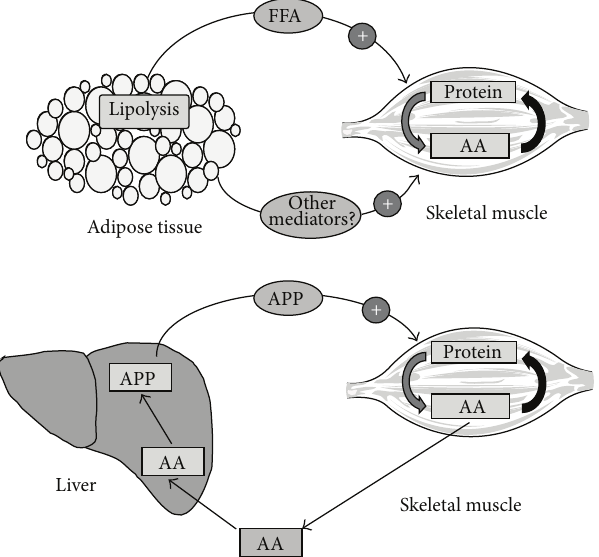
++ Figure 2: Examples of cross talk between adipose tissue/liver and skeletalmuscleduringcancercachexia. Adiposetissuereleasessome factor(s), possibly fatty acids, that seem to be essential to acti- vate muscle proteolysis. Indeed, recent evidences, using knockout deficient mice, suggest that blocking lipolysis in white fat results in an amelioration of muscle wasting. Similarly, liver acute-phase proteins (APP), such as serum amyloid A (SAA), could participate, alone or in synergy with cytokines, in activating muscle wasting by enhancing protein